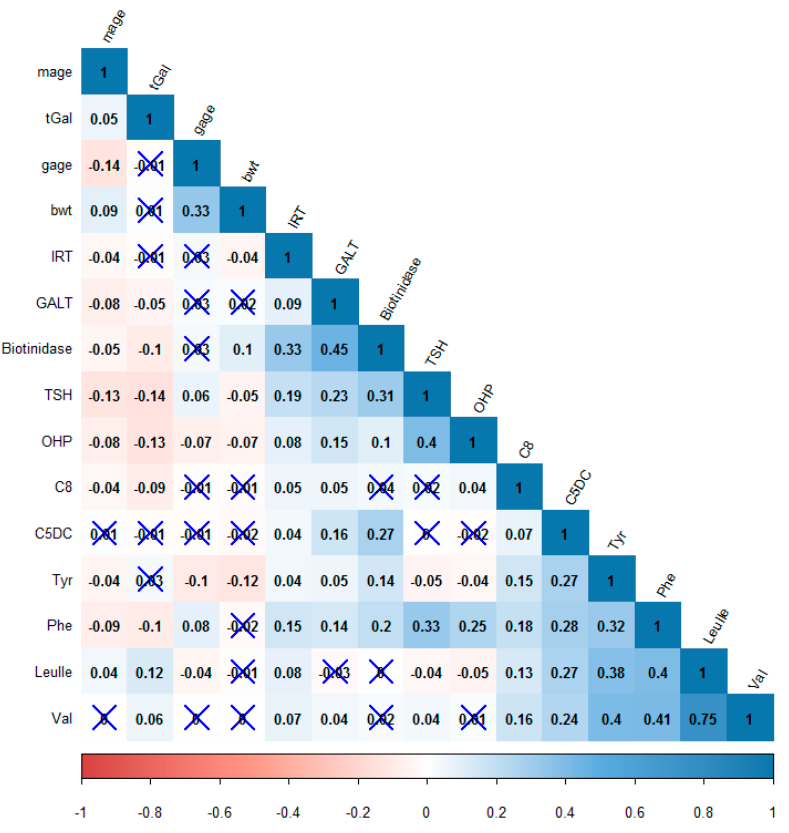
Figure 2. A Pearson’s correlation matrix heat map of the parameters measured in the study. Red—negative correlation, Blue—positive correlation. Correlations with insignificant p -values are marked with an “X”. mage = Mother’s age, gage = gestation age, and bwt = birth weight.